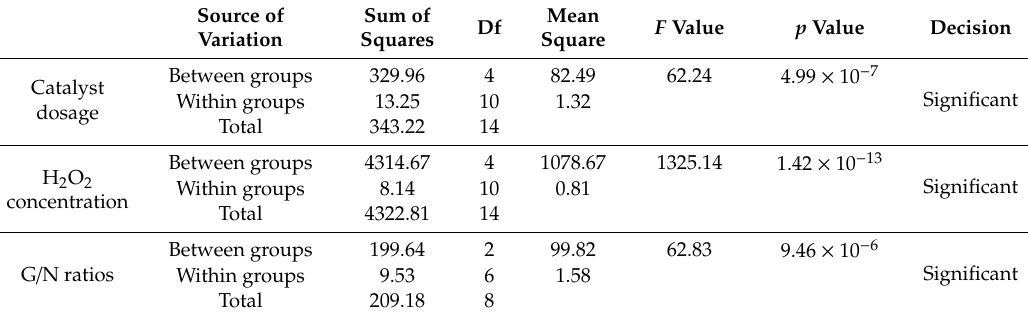
Table 2. One-way ANOVA results of various Cu-based nanoparticles e ff ects on the degradation of NP9EO.